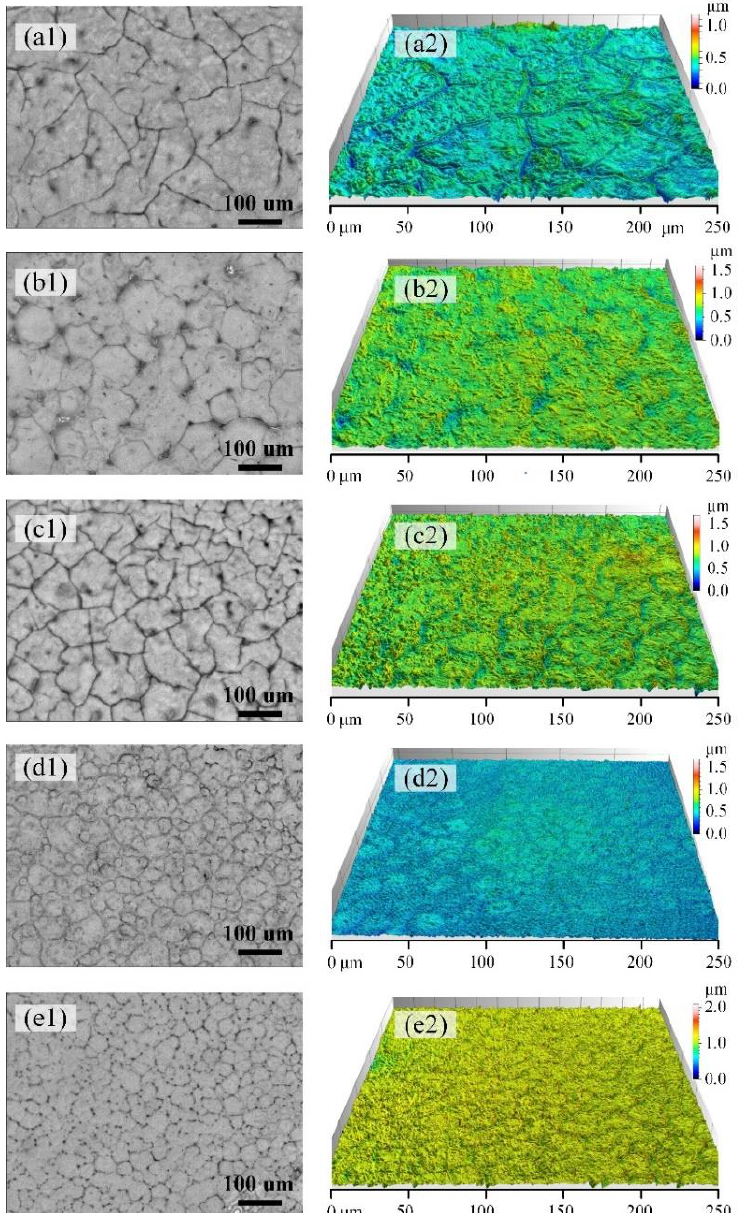
Figure 1. Morphology images of PLLA samples after crystallization treatment at a temperature of 80 ◦ C: ( a1 – e1 ) show the microscopy images of PLLA1, PLLA2, PLLA3, PLLA4 and PLLA5, respectively. The three-dimensional images of ( a1 – e1 ) were obtained by CLSM and are shown in ( a2 ) – ( e2 ), respectively.